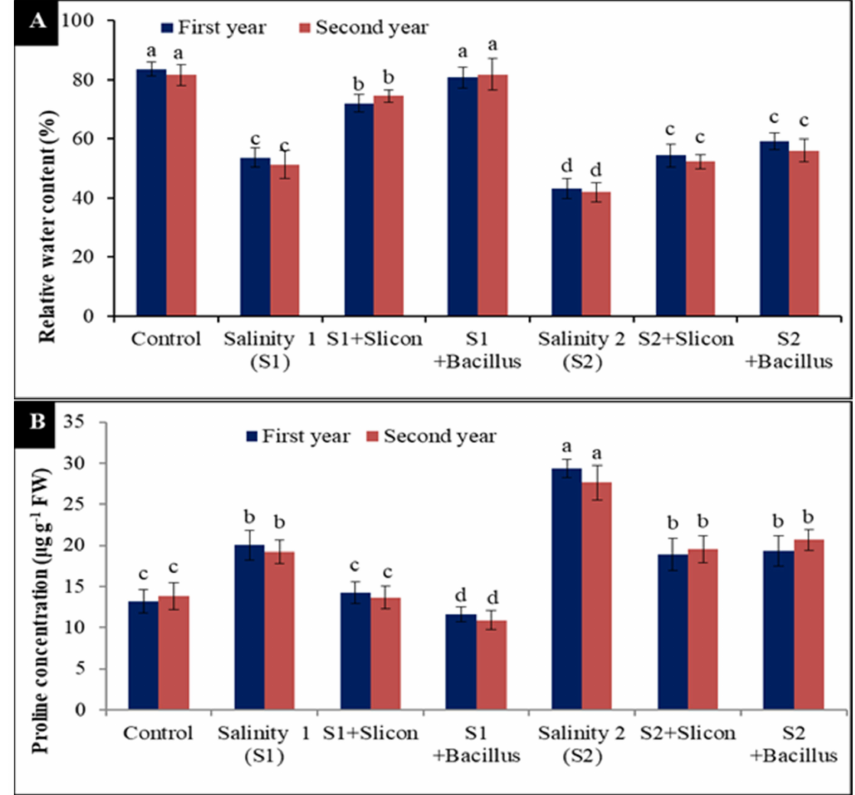
Figure 3. Effect of Si (potassium silicate at 2.7 mmol L − 1 ) and B. thuringiensis on RWC ( A ) and proline content ( B ) in lettuce plants under salinity during two seasons (2019/2020 and 2020/2021). Different letters on the columns show significant differences between the treatments according to ANOVA, Duncan’s multiple range test at 0.05 level. Data is the mean ( ± SE) of tree replicates. Salinity 1 (S1): 4 dS m − 1 , Salinity 2 (S2): 8 dS m − 1